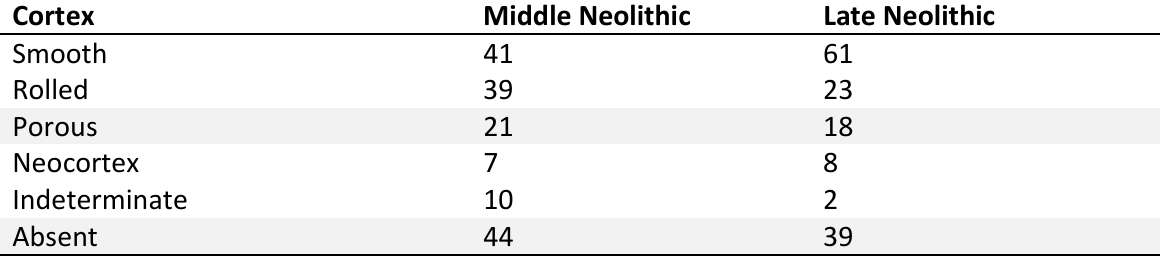
Table 4. Proportion of Middle and Late Neolithic pieces by cortex